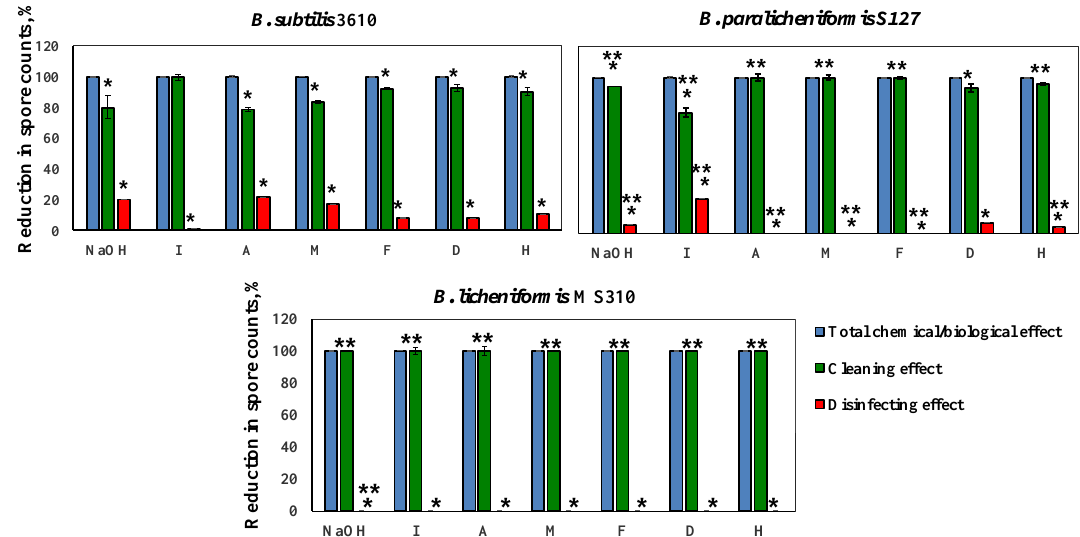
Figure 5. Correlation between the cleaning and disinfecting effects of the examined agents for each tested strain. Caustic soda and different cleaning solutions—I, A, M, F, D, and H (compositions are described in Methods)—were added to the tubes, with spore suspension, of the tested Bacillus isolates and incubated for 10 min at 50 °C, 250 rpm. The ability of a cleaning agent to reduce the number of viable spores was defined as the disinfecting effect. The percentage of the disinfecting effect was compared to the total chemical/biological effect of a cleaning agent (taken as 100%). The difference between the total chemical/biological effect of a cleaning agent and the disinfecting effect was defined as the cleaning effect. The results represent the means and standard deviation (SD) of two independent biological experiments, performed in duplicate. * Statistically significant difference ( p < 0.05) between the reduction in the spore counts due to the cleaning or disinfecting effects versus the total chemo-biological effect of a tested agent. ** Statistically significant difference ( p < 0.05) between the reduction in the viable spore counts in a given sample and the reduction in the spore counts for B. subtilis 3610 (control).